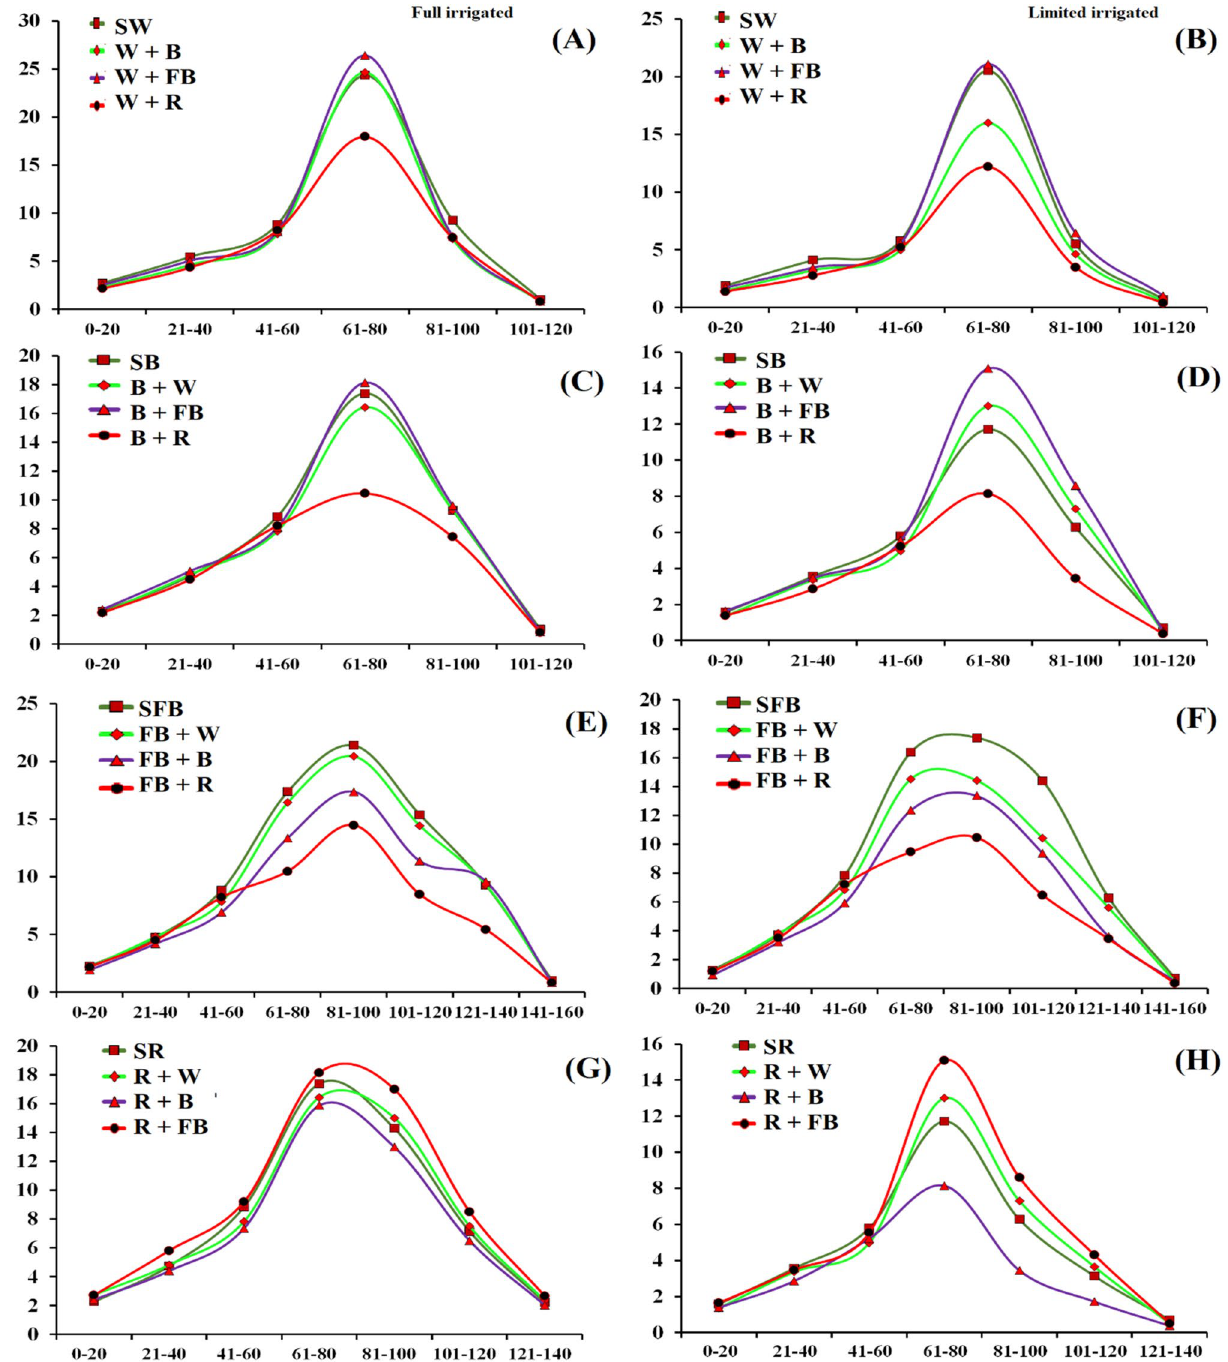
Figure 1. Crop growth rate of winter cereal and legumes crops as affected by intercropping and irrigation regimes. W, B, FB and R, stand for wheat, barley, fababean and rapeseed,